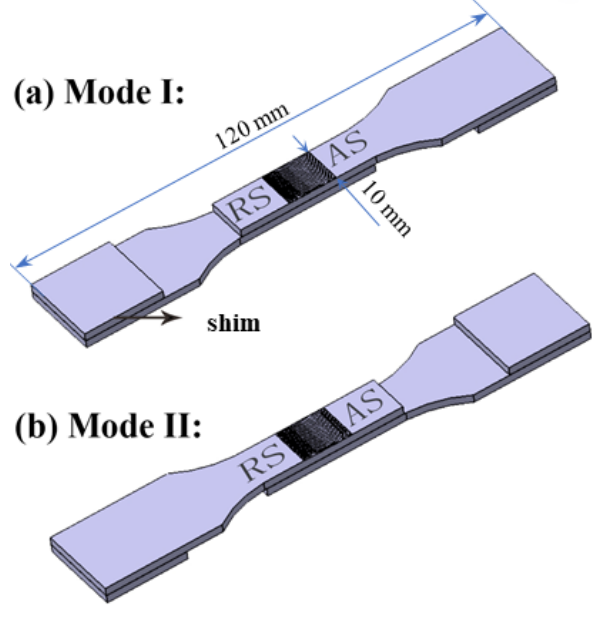
Figure 2: Two different loading modes: (a) Mode I and (b) Mode II.